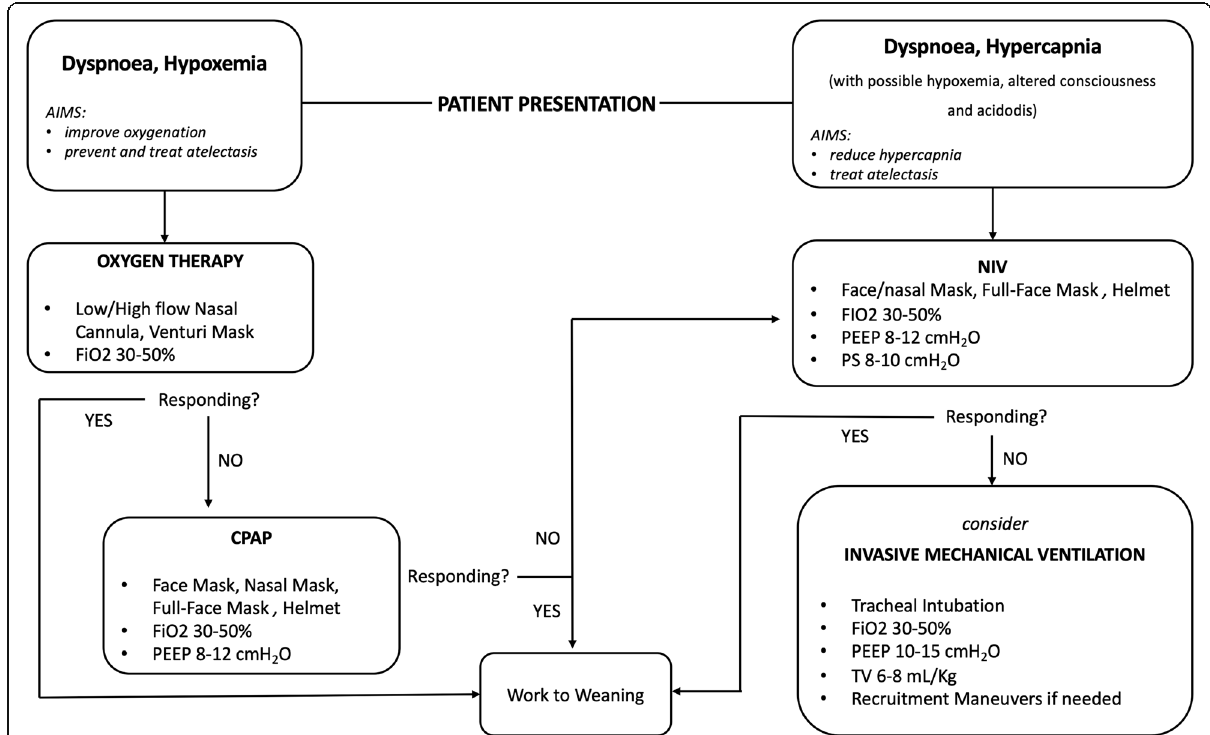
Fig. 1 Respiratory management of acute respiratory failure in obese patients. C-PAP, continuous positive airway pressure; NIV, non-invasive mechanical ventilation; PEEP, positive end-expiratory pressure; TV, tidal